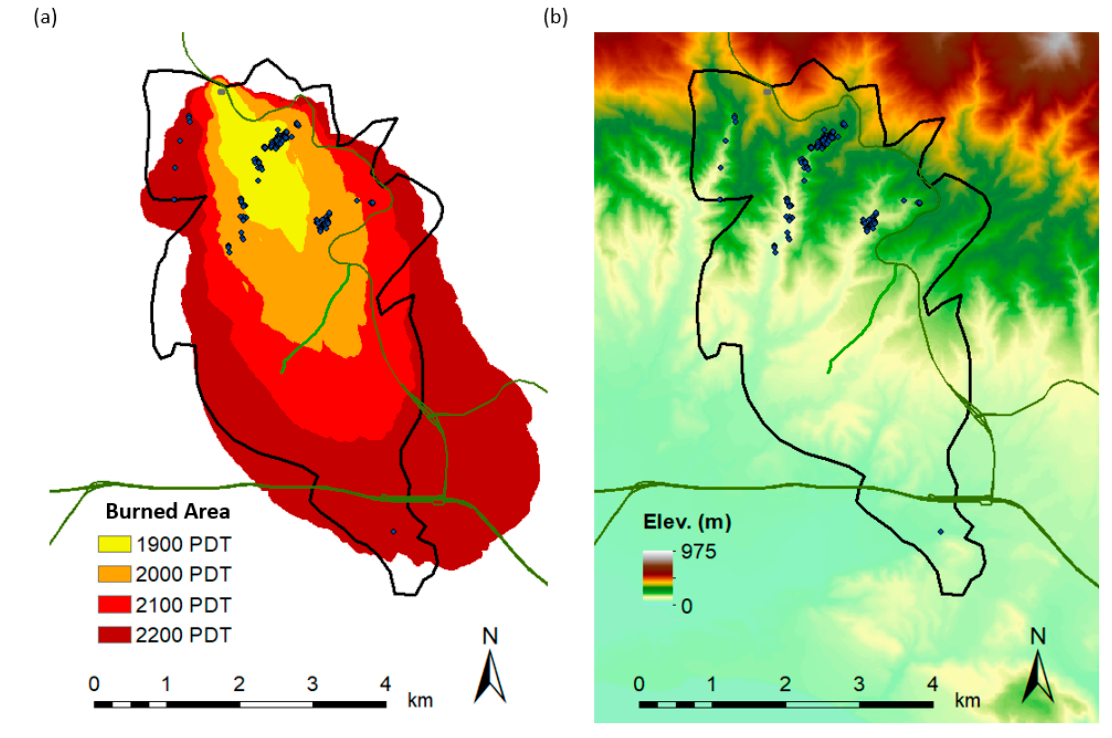
Figure 8. ( a ) Similar to Figure 7, except the simulated burn areas (colored polygons) are from the all-grass fuel map simulation. Blue dots indicate ember launch locations for spot fires. ( b ) Same as ( a ) with elevation colored.